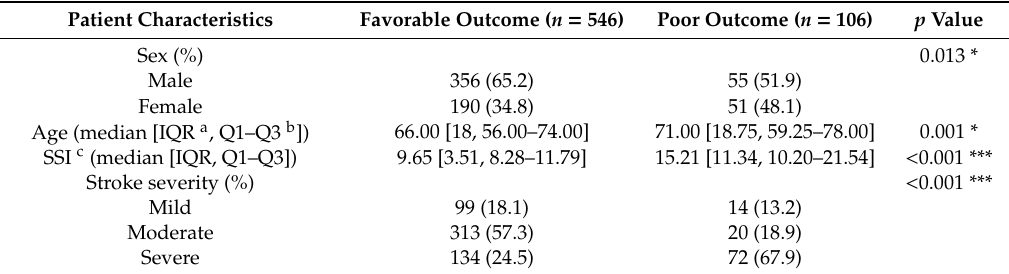
Table 2. Univariate analysis of the laboratory results.